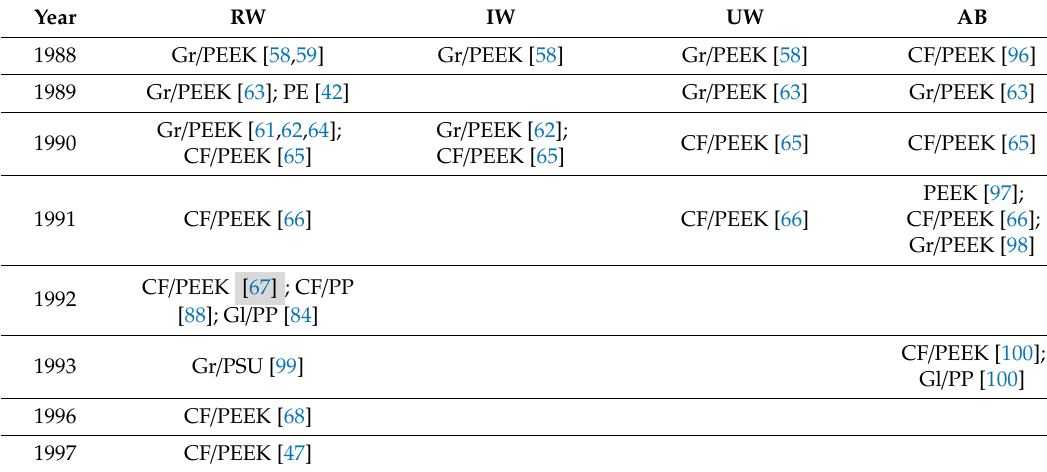
Figure 2. ( a )—Main thermoplastic composite materials used in fusion bonding research techniques: Graphite fiber / PEEK [58–64]; Carbon fiber / PEEK [23,47,60,65–77] Carbon fiber / PEI [69,78–82]; Glass fiber / PP [34,40,83–86]; Carbon fiber / PPS [29,32,33,48,87]; Carbon fiber / PP [36,70,88]; PE / HDPE [42,89,90]; Glass / PEI [31,80]; Glass fiber / PA [83,85]; Carbon fiber / PA [36,91]; Glass fiber / PPS [92,93]; PU + Fe particles [94]; Polymethylmethacrylate (PMMA) [95]. Keywords of the search scope: “Fusion bonding”, “Resistance welding”; “induction welding”; “ultrasonic welding”. ( b )—Distribution of manufacture techniques to perform bonded and welded joints on the thermoplastic composite materials presented in Figure 2a. Table 1. Chronological representation of TPC materials applied in Resistance welding (RW), Induction welding (IW), Ultrasonic welding (UW), and Adhesive Bonding (AB) procedures. Gr—Graphite fiber; Gl—Glass fiber, CF—Carbon fiber. Highlighted references represents works including numerical